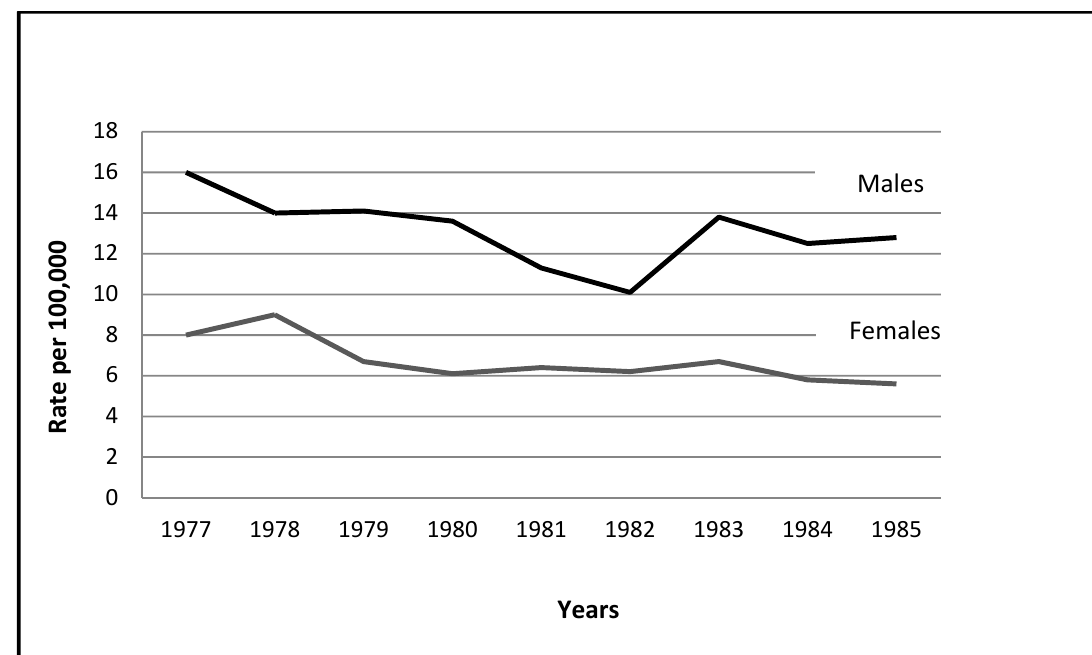
Figure 3. Time-Plot: The 1st Lebanon War